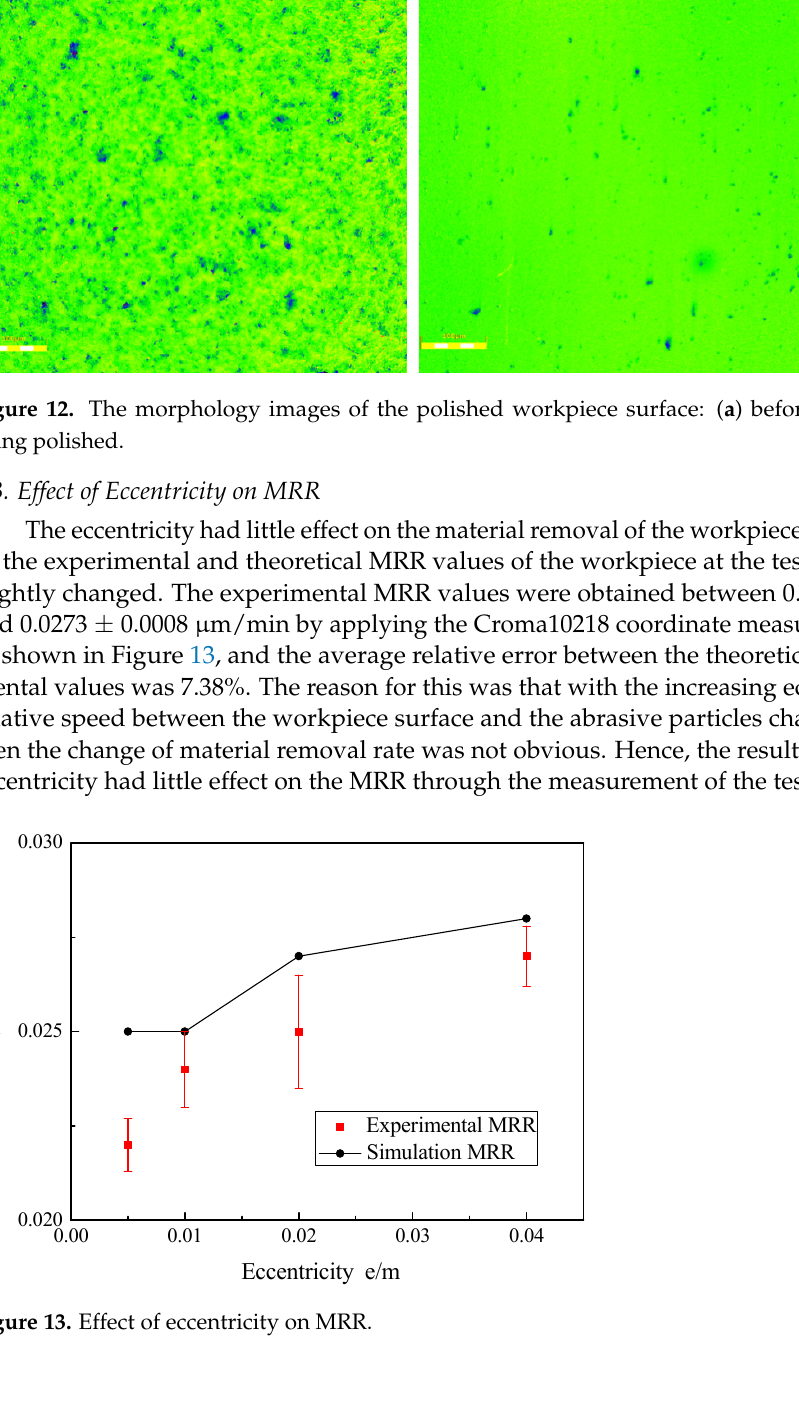
Figure 11. Effect of eccentric wheel rotation speed on MRR.